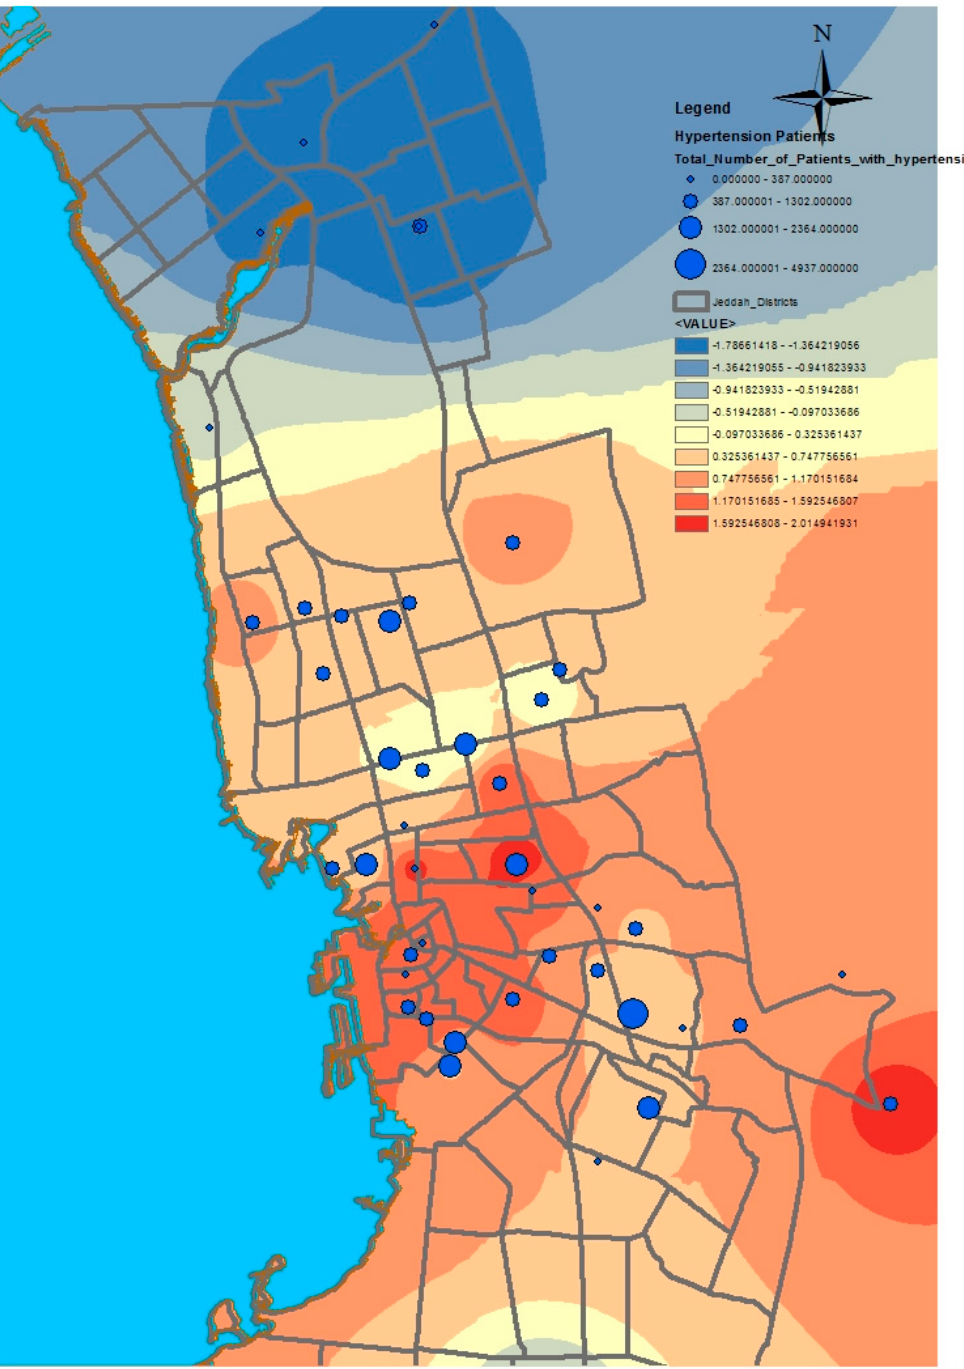
Figure 11. Hotspot analysis for hypertension patients.